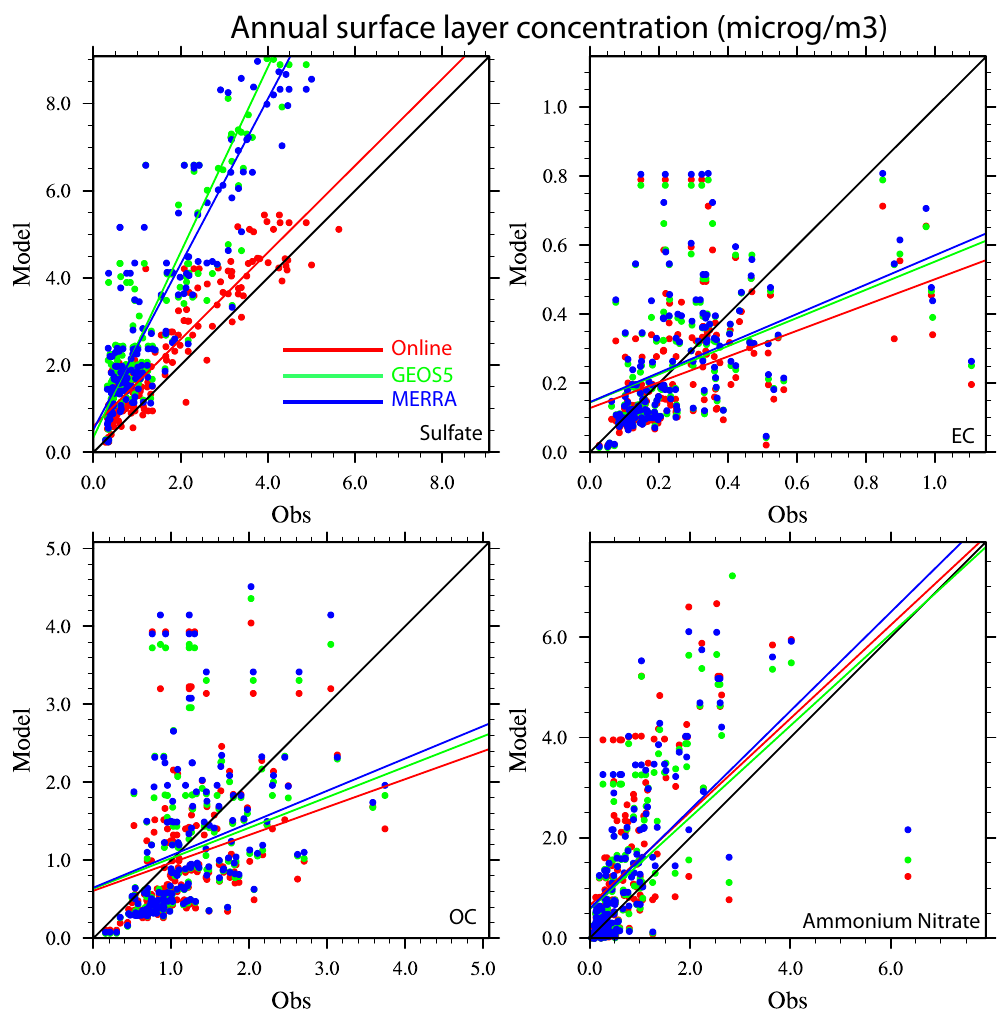
Fig. 16. Linear correlation between observed (IMPROVE sites, black line) and modeled (interpolated to observation sites) annual surface concentrations of aerosols (sulfate, top left; elemental carbon, top right, organic carbon, bottom left, ammonium nitrate, bottom